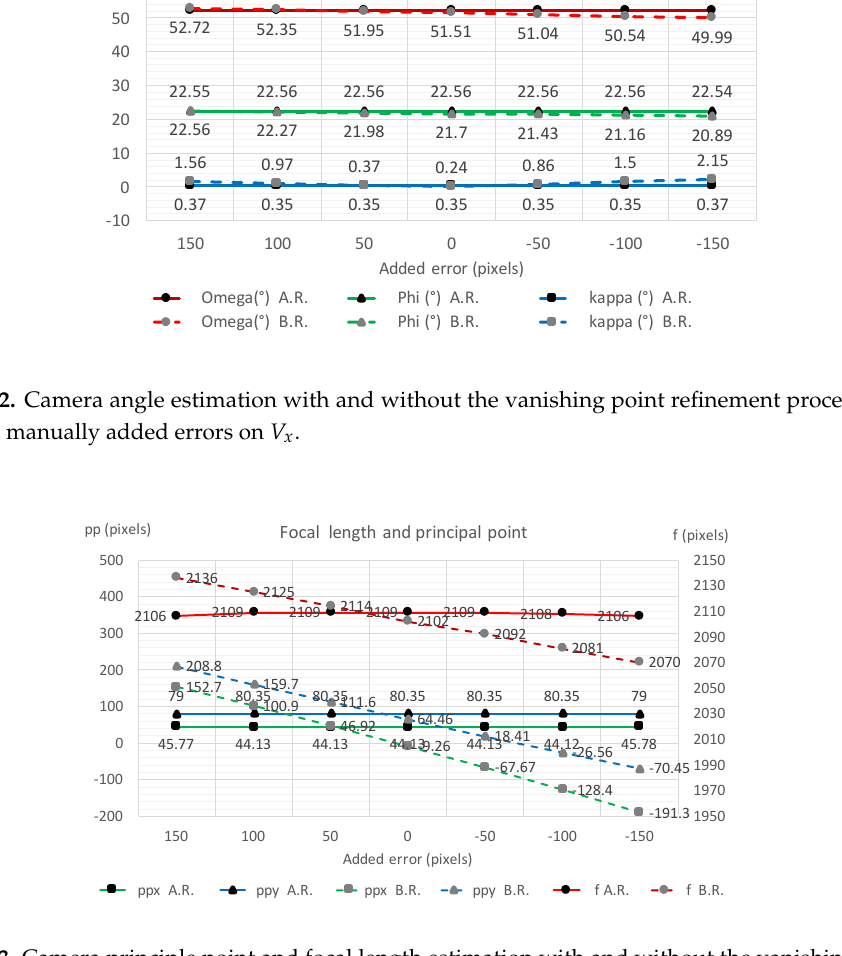
Figure 13. Camera principle point and focal length estimation with and without the vanishing point refinement process with different manually added errors on V x .